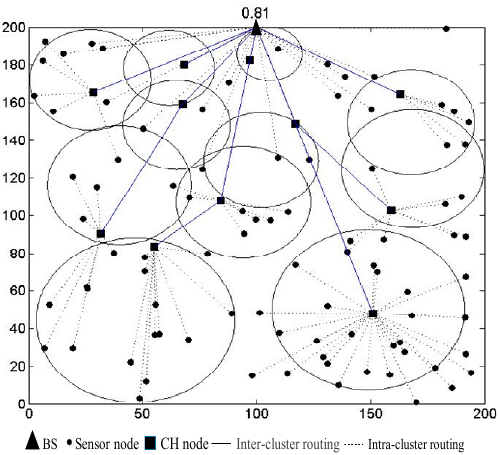
Figure 14. Routing diagram in simulation environment.